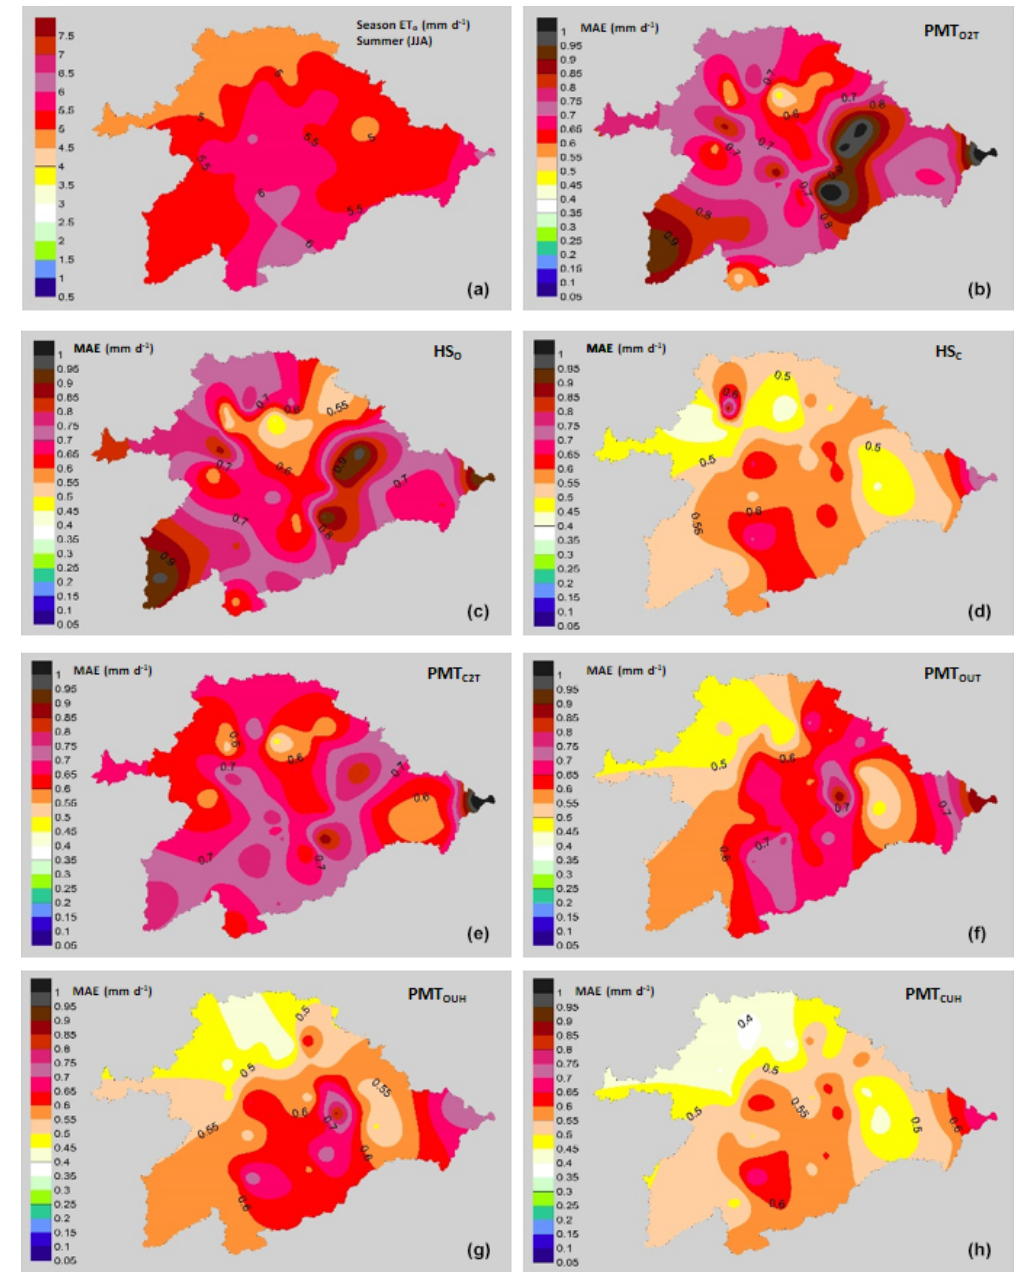
Figure 6. Performance of the models with a summer focus (June, July and August). (a) Average values of ET o (mmd − 1 ) in summer. Mean values of MAE (mmd − 1 ): (b) PMT O2T model, (c) H O model, (d) H C model, (e) PMT C2T model, (f) PMT OUT model, (g) PMT OUH model and (h) PMT CUH